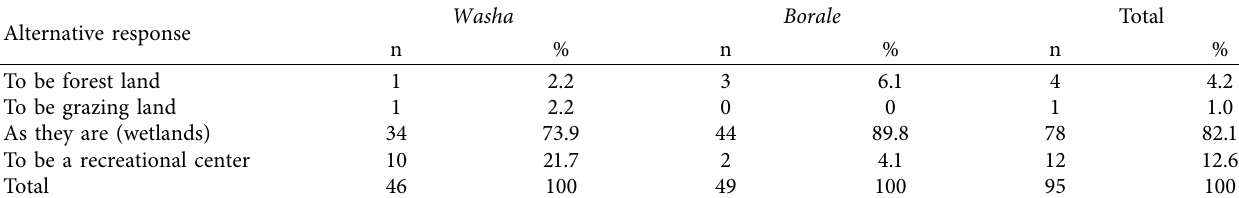
Table 10: What was your preference for the artificial wetlands to be in the future? Alternative